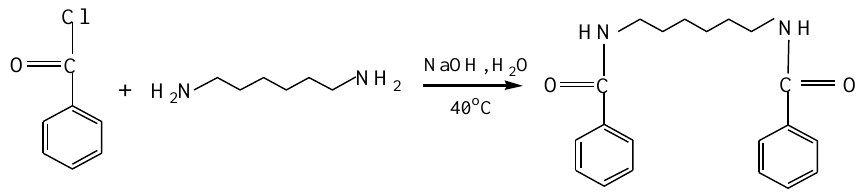
Figure 1. The mechanism of the derivative reaction of HMDA.